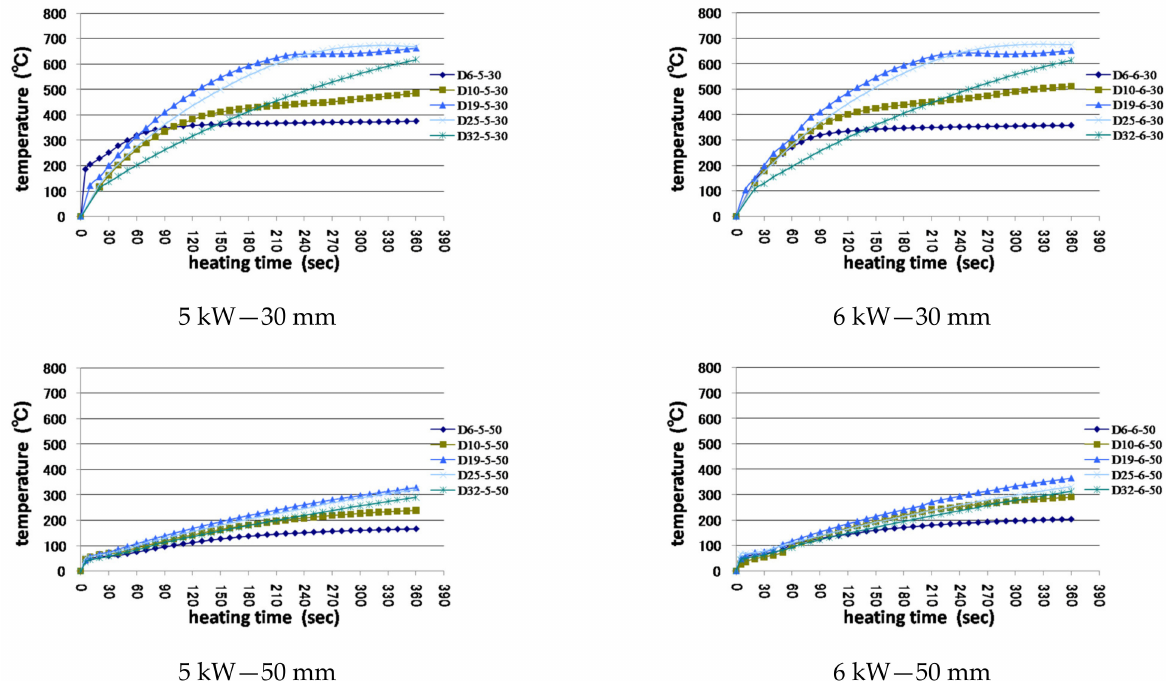
Figure 7. Temperature-rise characteristics of rebar during induction heating (150 mm—center). (D00-0-0, D reinforcement type; output, kW; distance,